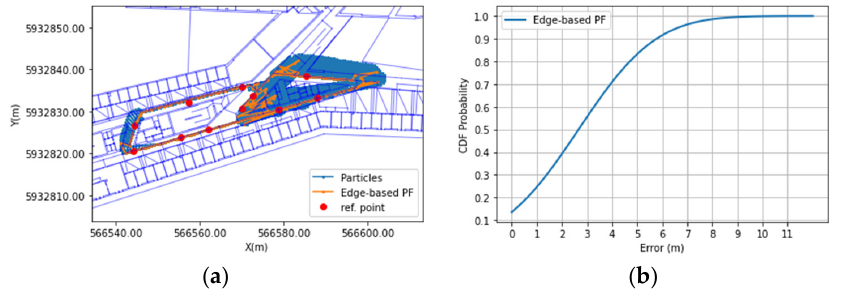
Figure 7. Edge-based PF: ( a ) The trajectory, including the route graph; and ( b ) Error vs. CDF probability of the mentioned method.